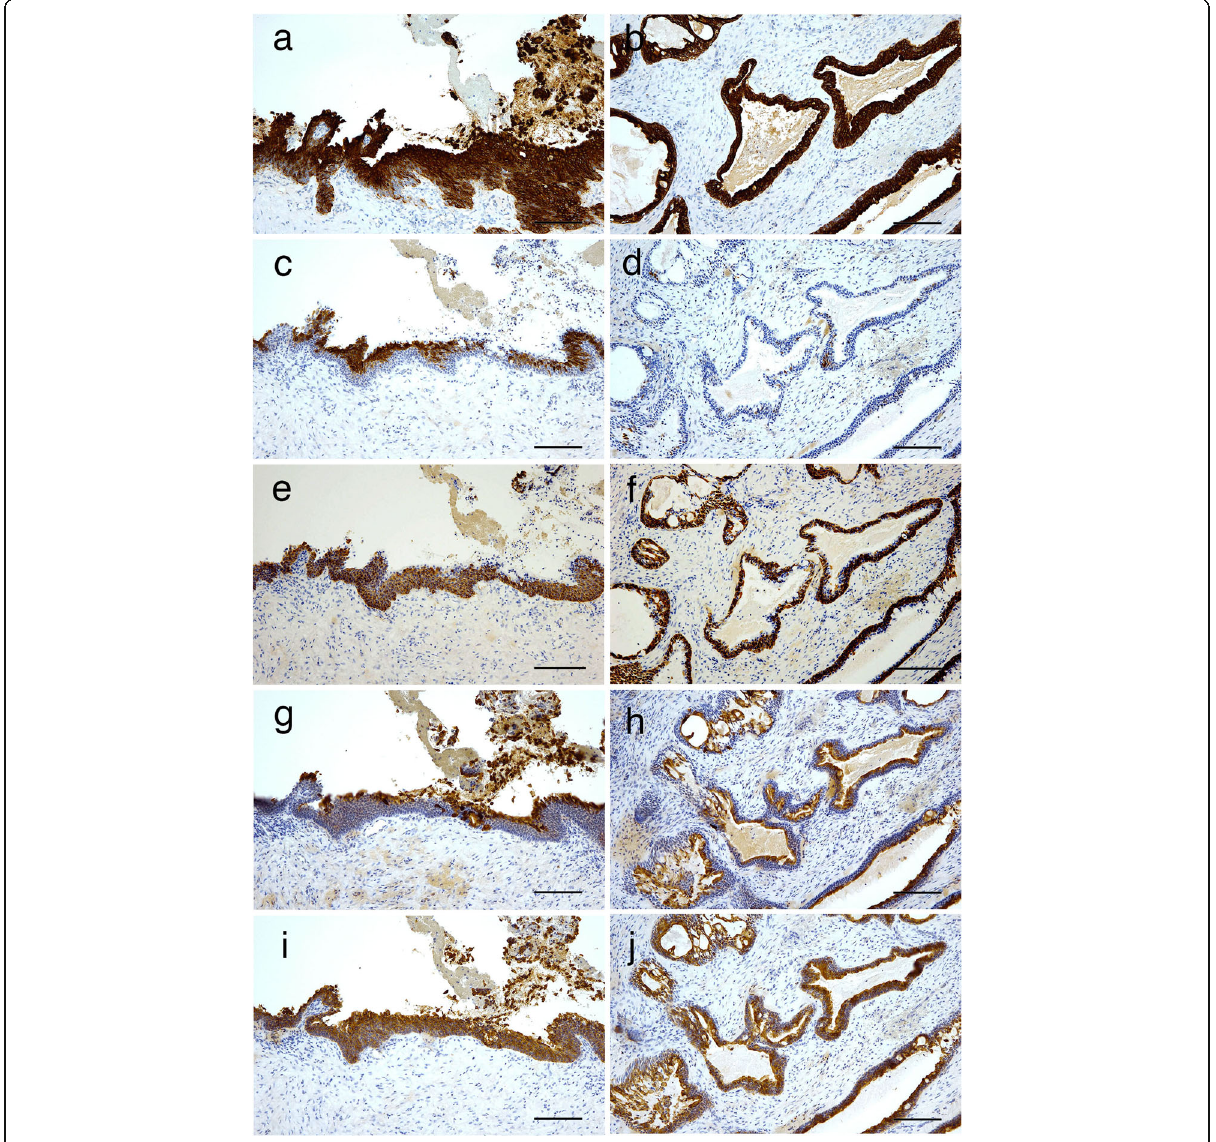
Fig. 3 Immunohistochemical profile of keratins in central MEC arising from a GOC. Immunoperoxidase stain for ( a, b ) CK7, ( c, d ) CK13, ( e, f ) CK14, ( g, h ) CK18, and ( I, j ) CK19. GOC parts expressed CK7, 13, 14, 18, and 19 ( a, c, e, g, i ). Central MEC showed immunoreactivity for CK7, 14, 18, and 19, but was negative for CK13 ( b, d, f, h, j ). Scale bars, 100 μ m ( a – j